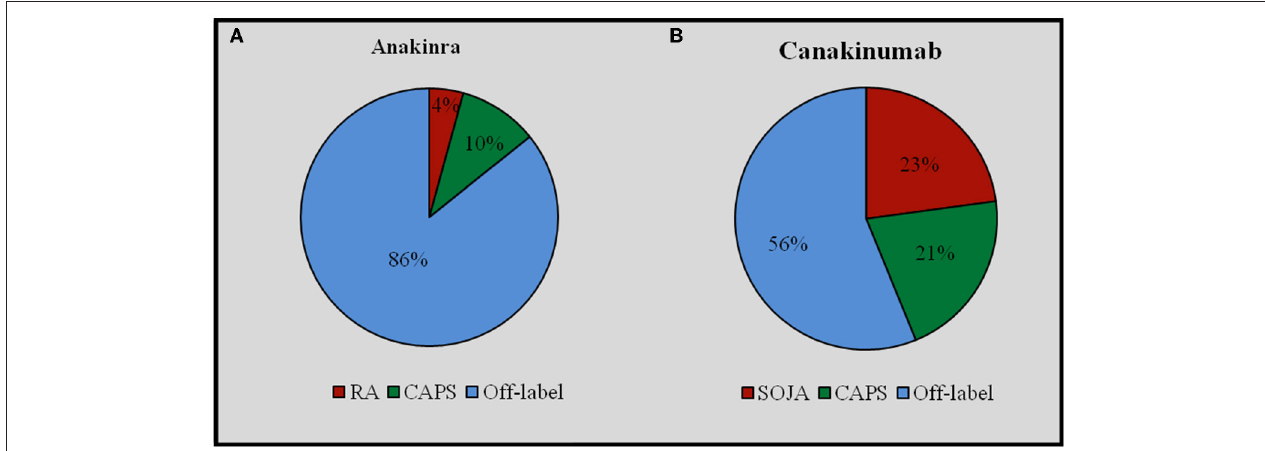
FIGURE 1 | On-label and off-label use of Anakinra (A) and Canakinumab (B). CAPS, Cryopyrin-Associated Periodic Syndrome; RA, rheumatoid arthritis; SOJA, Systemic Onset Juvenile Idiopathic